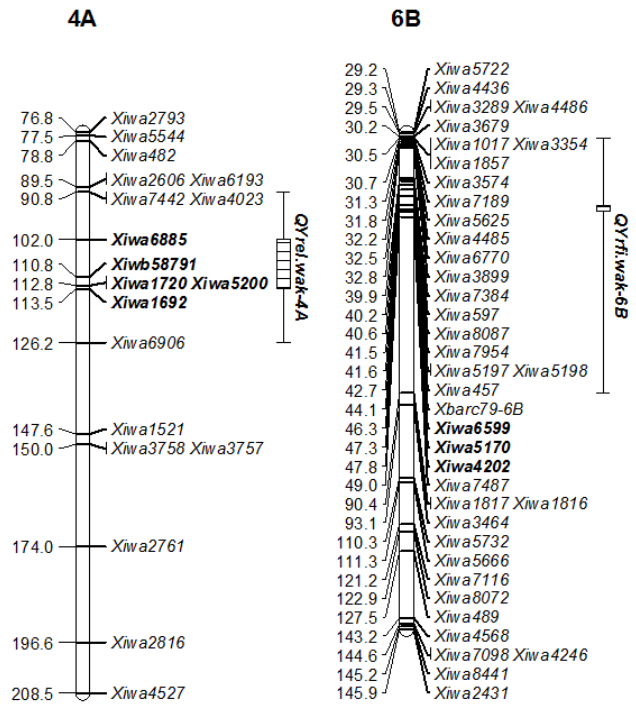
Figure 1. Quantitative trait loci (QTL) maps for QYrel.wak ‐ 4A and QYrfi.wak ‐ 6B in the Finch × Eltan recombinant inbred line mapping population. Markers in bold are associated with the respective QTL and were used to determine novelty of QTL in other germplasm.